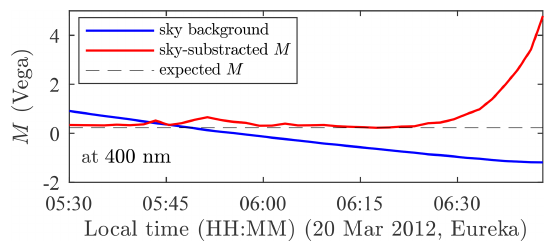
Figure 19. Apparent decrease in star brightness (increase in magni- tude M ) as the sky background brings the detector into a non-linear regime. The star brightness has been corrected for sky brightness (the latter has been subtracted from the former). The separate back- ground measurement (blue line) is not affected by the non-linearity of the detector as B < 8000cnts − 1 , but the sum F + B used to com- pute S is, leading to M = S + C , Eq. (13).